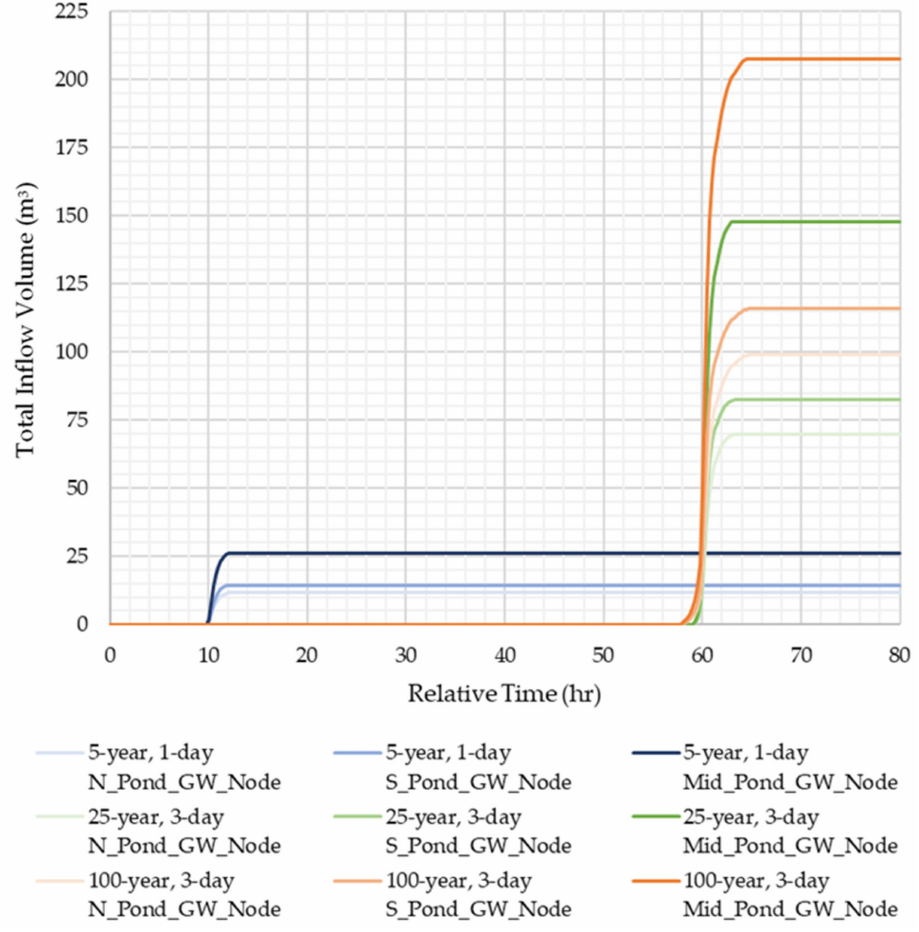
Figure 11. Total inflow infiltration volume for the 5-year 1-day, 25-year 3-day, and the 100-year 3-day design storm